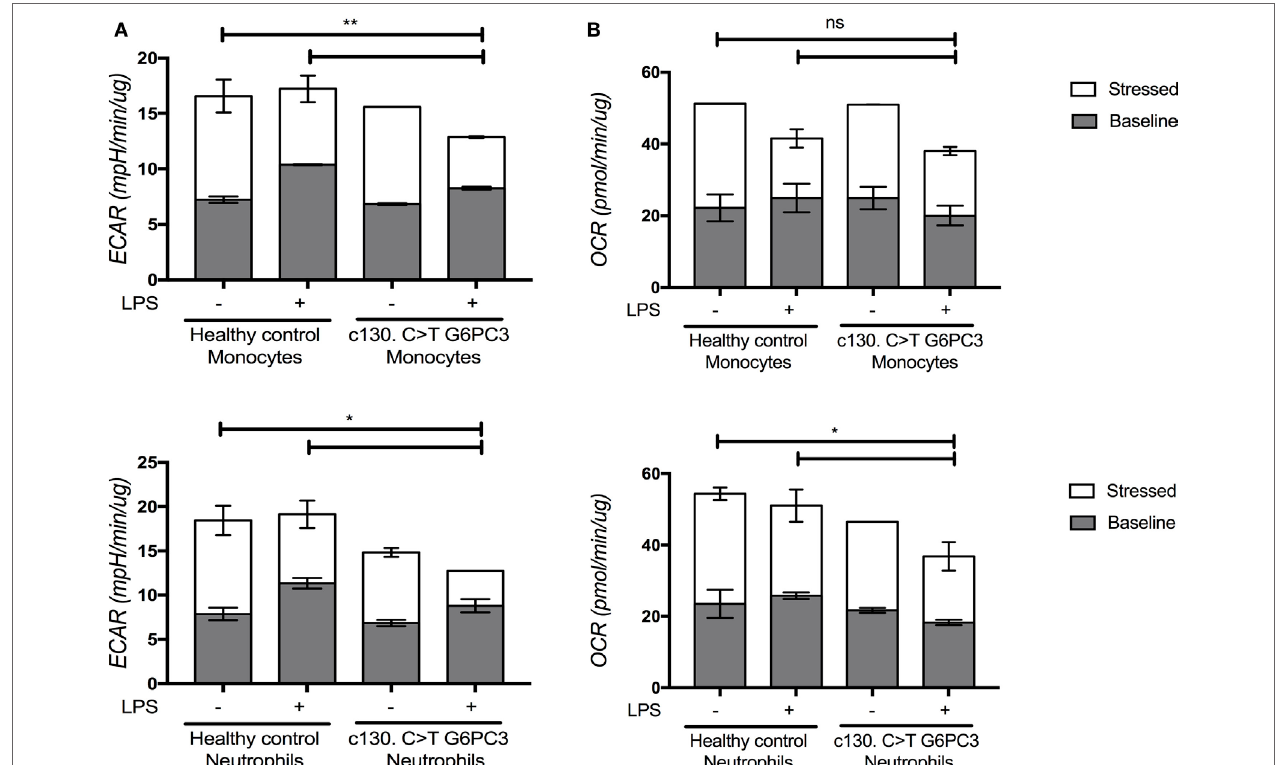
FIGURe 3 | Levels of glycolysis and oxidative phosphorylation within monocytes and neutrophils from patients and healthy controls under basal and stressed conditions, with and without lipopolysaccharide (LPS) stimulation. Neutrophils were separated from the erythrocyte/granulocyte layer using ammonium chloride red cell lysis buffer (Sigma) after separating PBMC from the whole blood using the lymphoprep technique. Monocytes were separated further using magnetic beads (Miltenyi Biotec) for monocyte negative selection. Granulocytes and monocytes were seeded into the Agilent 96-well flux plate at 5 × 10 5 cells/well in triplicate wells and stimulated with or without LPS (10 ng/mL) (Invivogen) for 4 h. The XFp Cell Energy Phenotype Test (Agilent) was performed using the Agilent Xfe Seahorse Extracellular Flux Analyzer. Extracellular acidification rate (ECAR) and oxygen consumption rate (OCR) were measured by the Agilent Seahorse Metabolic Profiler using the Basal Metabolic Phenotype Assay as an indirect measurement of glycolysis and oxidative phosphorylation (OXPHOS) within live cell cultures. The baseline levels (gray) represent glycolysis (a) or OXPHOS (B) within the cells before metabolic stressors. The stressed levels (superimposed bars in white) represent glycolysis or OXPHOS post-oligomycin and FCCP injection. The two-way ANOVA statistical test was used ( p < 0.05) and refers to the stressed (white)